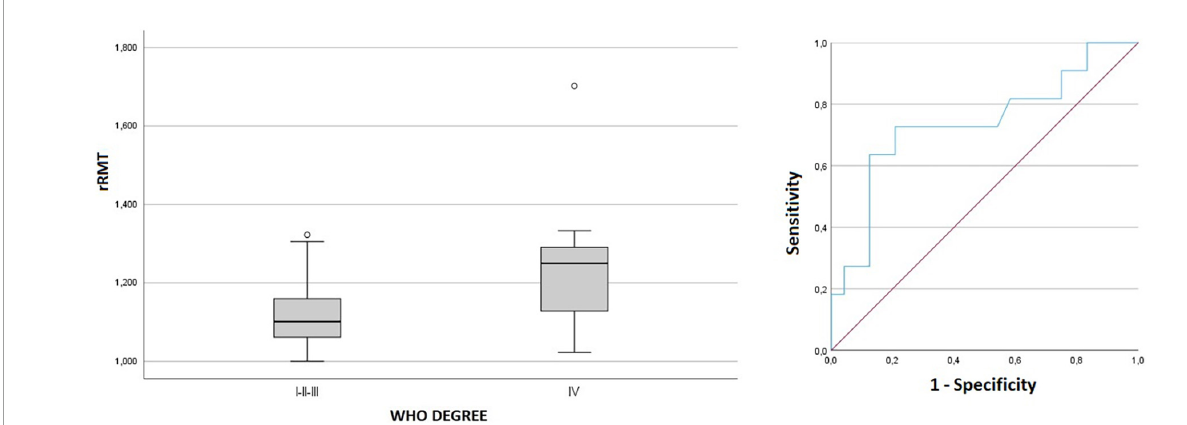
FIGURE5 Box plot and ROC curve of rRMT and tumor grading.